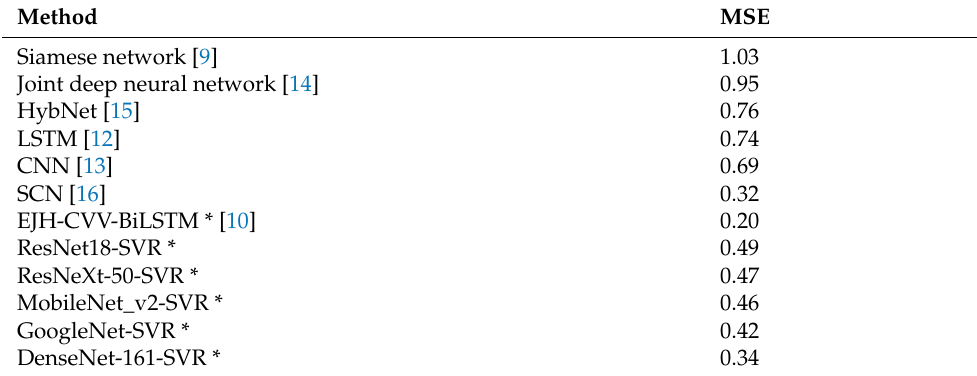
Table 8. Comparative analysis using state of the art methods on the UNBC-McMaster database. The indication (star *) precises data balancing is used.